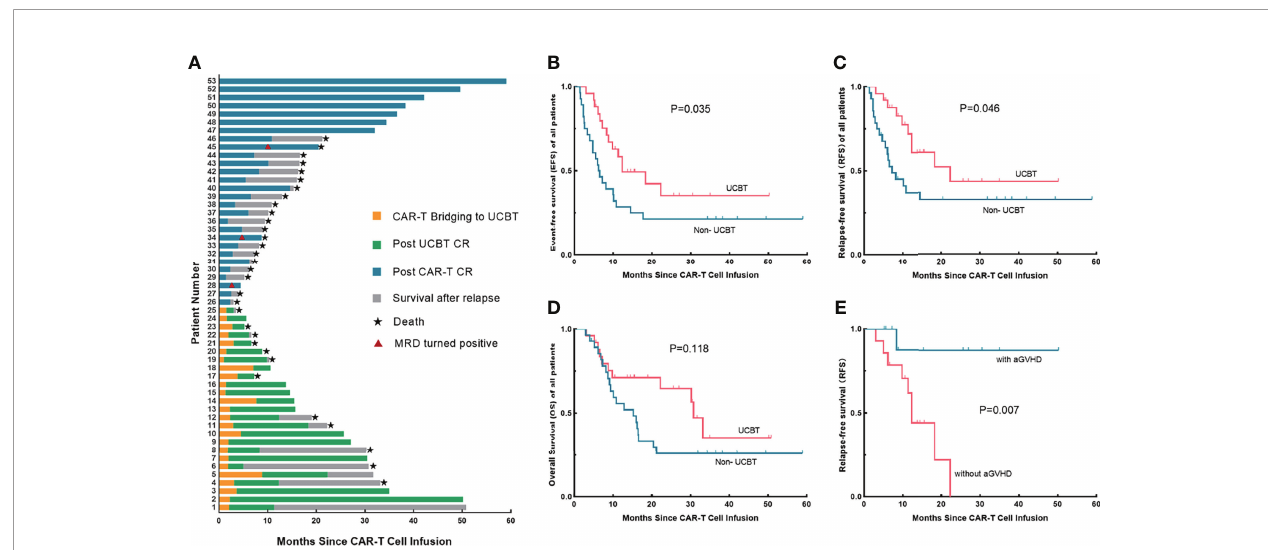
FIGURE 1 | Treatment responses and long-term survival of each patient, survival analysis between the UCBT group and the non-UCBT group, and the association between aGVHD and RFS in the UCBT group. (A) Disease status from CAR-T cell infusion to the end of follow-up of each patient. (B – D) Differences of EFS (B) , RFS (C), and OS (D) between the UCBT group and the non-UCBT group in overall patients. (E) The association between the occurrence of aGVHD and RFS of patients underwent consolidative UCBT after entering remission by CAR-T therapy. UCBT, unrelated cord blood transplantation; aGVHD, acute graft-versus-host disease; EFS, event-free survival; RFS, relapse-free survival; OS, overall survival; CAR, chimeric antigen